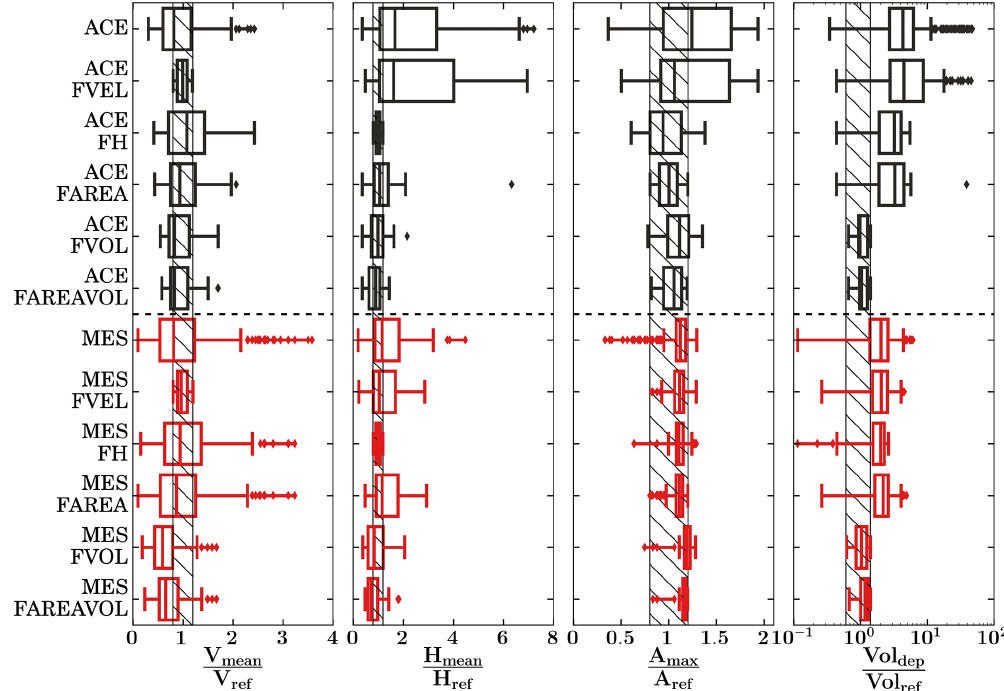
Figure 5. Effects of parametric uncertainty in normalized model responses for the original parameter sample (top panels) and alternative observational constraints – flow velocity (FVEL), flow depth (FH), flood area (FAREA) and sediment volume (FVOL) – and joint area– volume constraint (FAREAVOL). Results are displayed for Acerillas (black) and La Mesilla (red) creeks. The hatched area for V mean , H mean and A max corresponds to ± 20% of their reference values, and for Vol dep it is up to ± 40% of the estimated sediment volume. The vertical bold line in the boxplots is the median; the body of each boxplot shows the interquartile range ( Q 75 – Q 25 ); and the whiskers represent the sample minima and sample